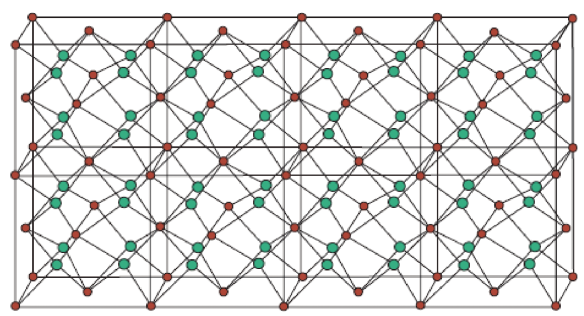
Figure 5: The graph of T